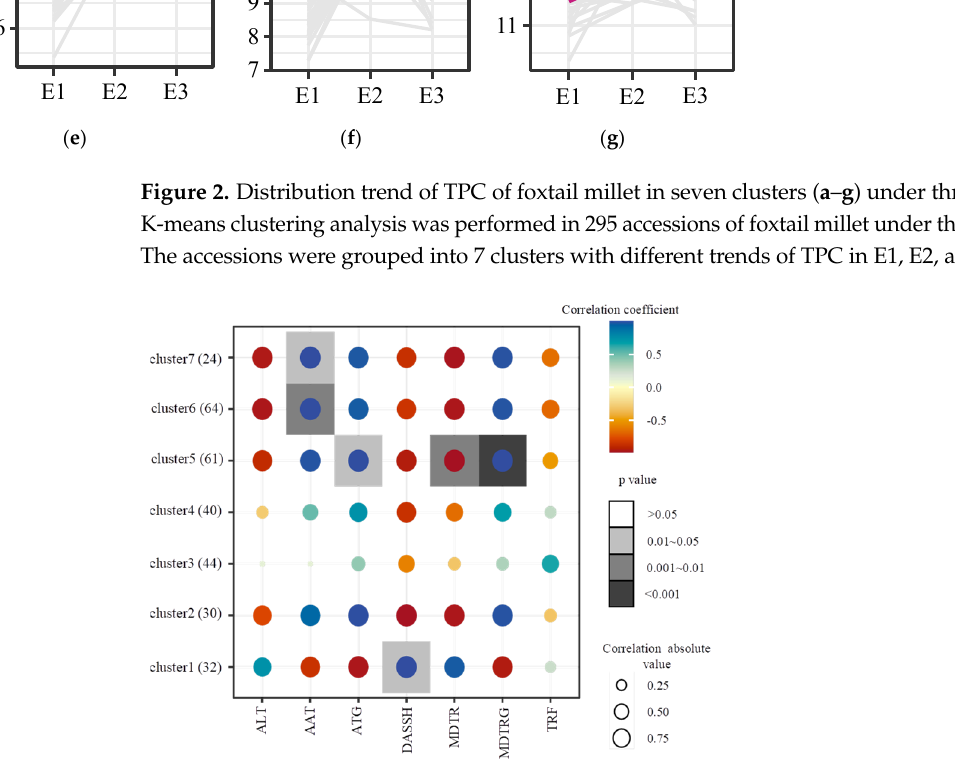
Figure 3. Correlation analysis between different clusters and climate data. ATG: accumulated temperature of ground-surface; AAT: accumulated temperature; MDTRG: mean diurnal temperature range of ground-surface; MDTR: mean diurnal temperature range; TRF: total rain fall; DASSH: daily average sunshine hours; ALT: altitude. The Pearson correlation coefficient was calculated by the ‘cor’ function in R software. The heatmap graph was plotted by ggplot2 in R software (R verson 3.4.1, Bell Laboratories, Union County, NJ, USA).